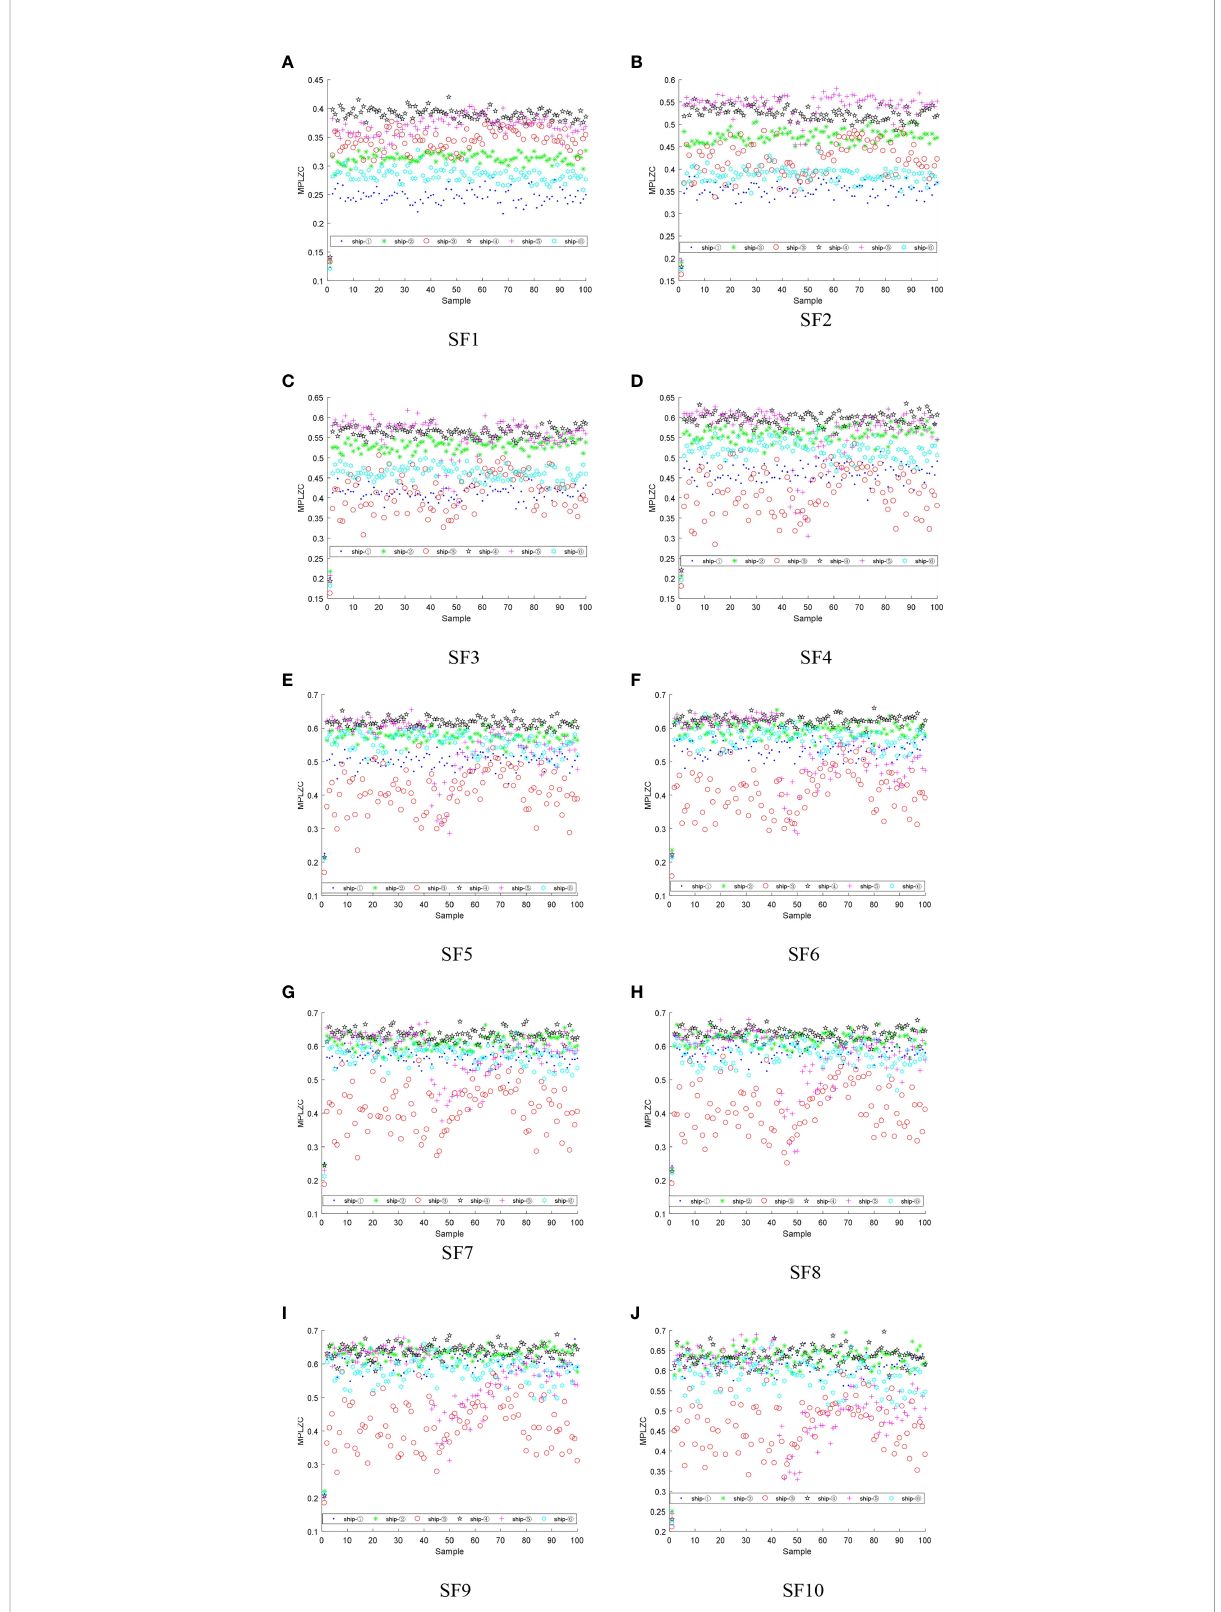
FIGURE 9 The feature distributions of MPLZC for six S-Ss under each SF: (A) SF1, (B) SF2, (C) SF3, (D) SF4, (E) SF5, (F) SF6, (G) SF7, (H) SF8, (I) SF9, (J)